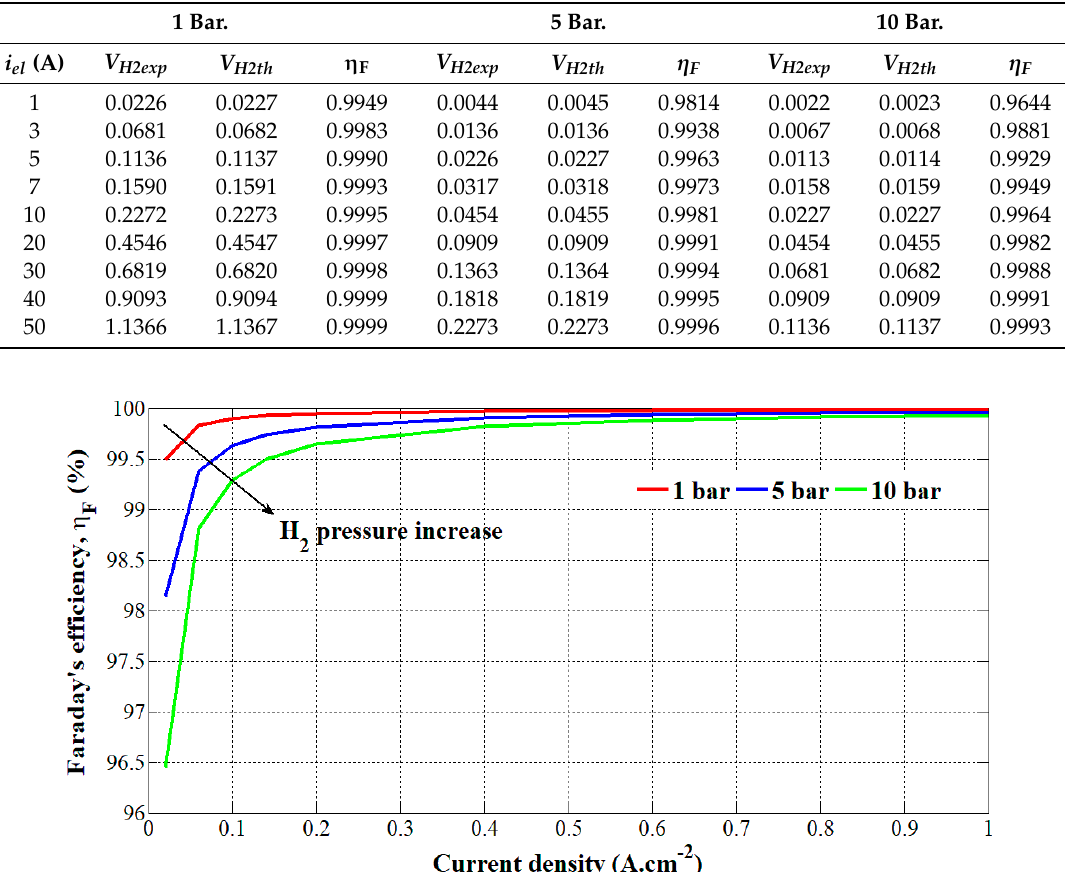
Table 2. Theoretical and experimental hydrogen flow rate for a hydrogen pressure of 1,5, and 10 bar.